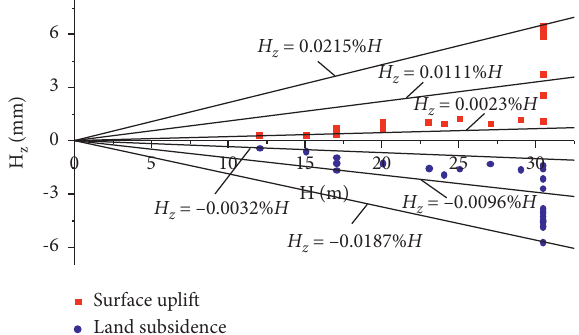
Figure 11: The relationship between the maximum surface uplift, settlement, and excavation depth.